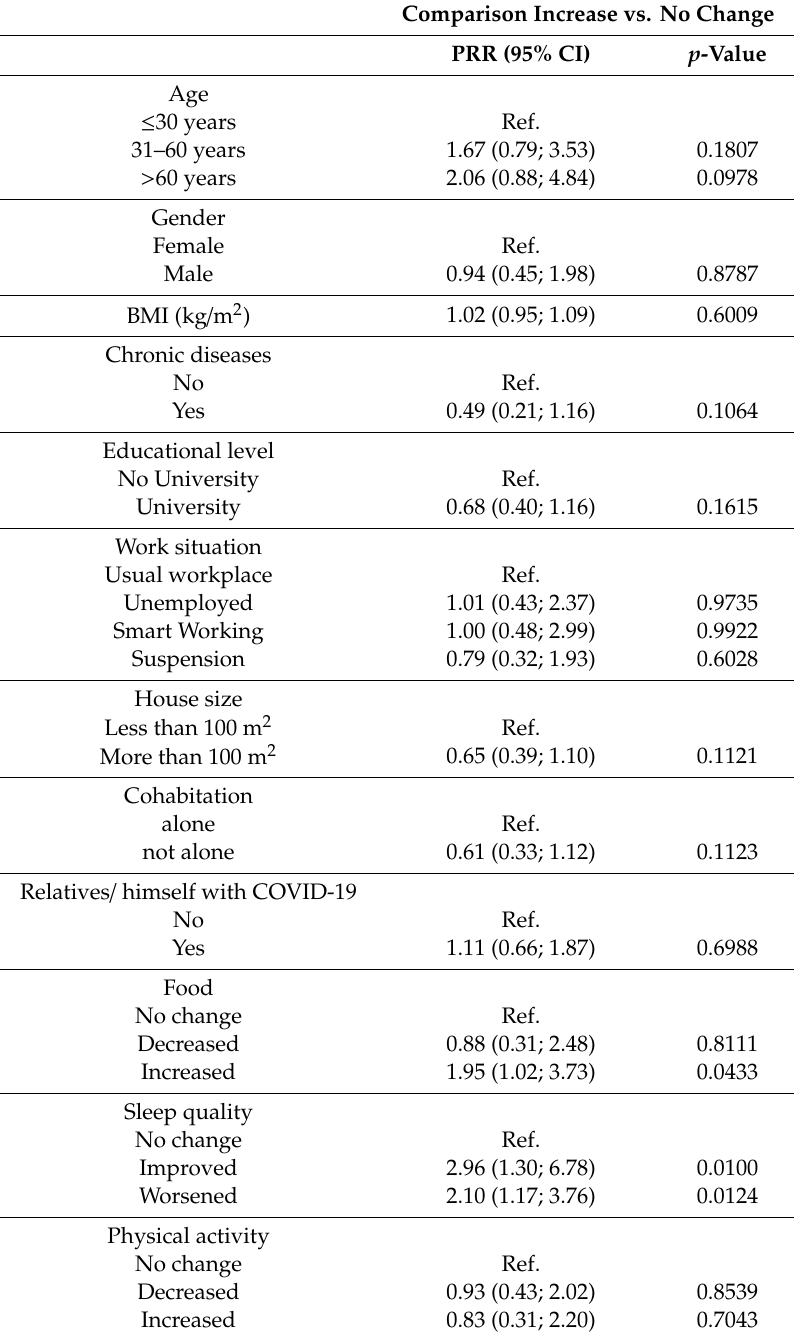
Table 5. Prevalence Risk ratio (PRR) for the increase in cigarette